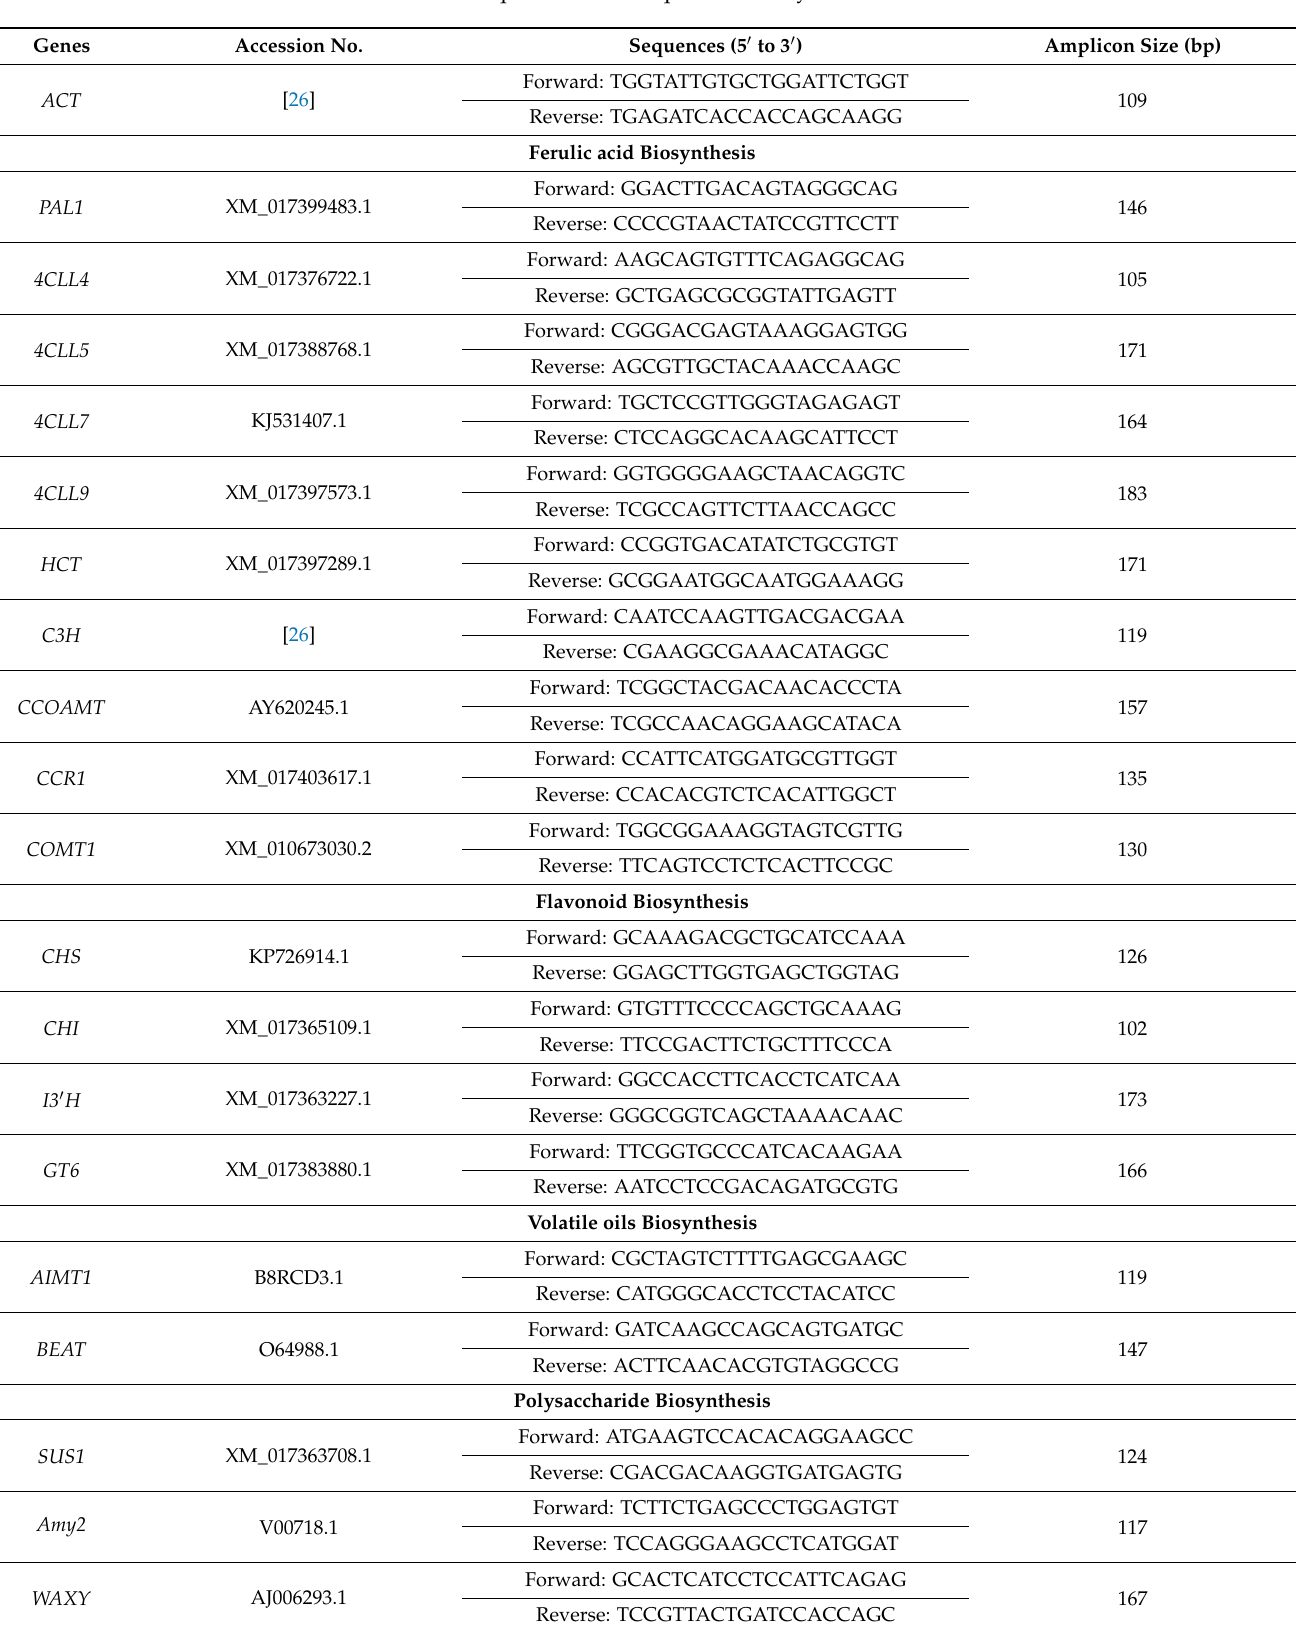
Table 1. Primer sequences used in qRT-PCR